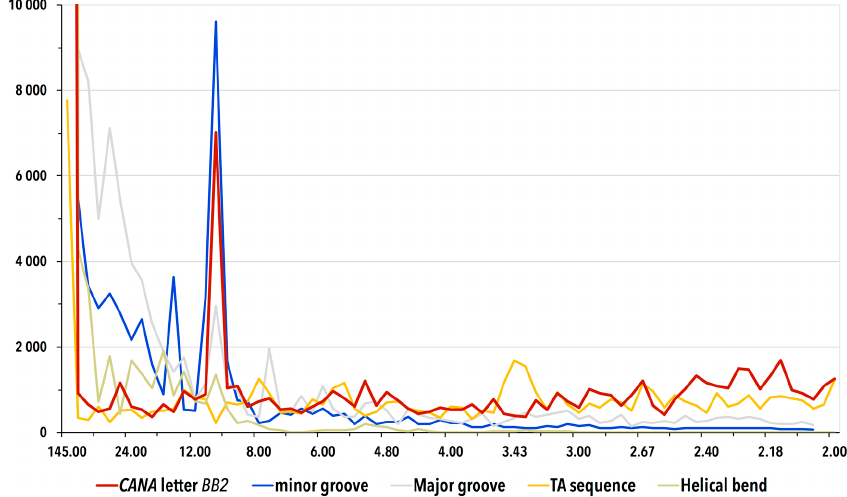
Figure 5. Periodograms of the occurrence of the CANA letter BB2, the minor and major groove widths, TA sequence, and helical axis bend along the DNA in NCP calculated by discrete Fourier transform. The periodograms display the signal averaged from 32 chains in the fifteen analyzed histone structures. The vertical axis measures intensity of the FFT signal, the horizontal axis is labeled as 1/frequency and shows potential periodic behavior. The signal with periodicity of ~10 steps, i.e., 11 nucleotides for the BB2 CANA letter and the minor groove width is strong with intensities well above the values of their respective estimated standard deviations. The high intensity peaks near periodicity of 145 nucleotides are numerical artifacts of the Fourier transform caused by the length of DNA strands, which are about 145 nucleotides long.